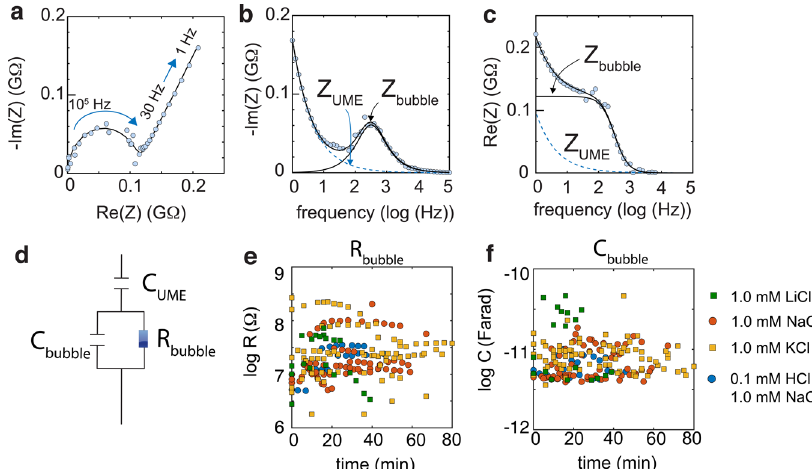
Fig. 2 EIS data and model predictions and parameters. a Example of a typical Nyquist (complex-plane impedance) plot showing real (Re) and imaginary (Im) impedance (Z) data (blue circles) and model (lines) of an oxygen bubble pinned on hematite in an aqueous solution of 1.0 mM NaCl at 25 °C. Measurements were collected over an applied alternating current of ±50 mV in the 1 – 10 5 Hz range through an ultramicroelectrode (UME). b , c Frequency- resolved b imaginary and c real impedance data (blue circles) alongside predicted contributions from the bubble and the UME (lines). d Equivalent circuit model used to predict bubble polarization resistance (R bubble ) and double layer capacitance ( C bubble ), alongside UME capacitance ( C UME ). e R bubble and f C bubble values from repeated EIS measurements on 29 different oxygen bubbles pinned on hematite in four different ionic media (green square = 1.0 mM LiCl, red circle = 1.0 mM NaCl, yellow square = 1.0 mM KCl, blue circle = 0.1 mM HCl + 1.0 mM NaCl), and for repeated measurements on single bubbles over a period of up to 80 min. Supplementary Figs. 3 – 4 contain the complete set of model parameters and distributions of these values. Supplementary Fig. 5 shows similar ranges of model parameter values for bubbles pinned on gold.